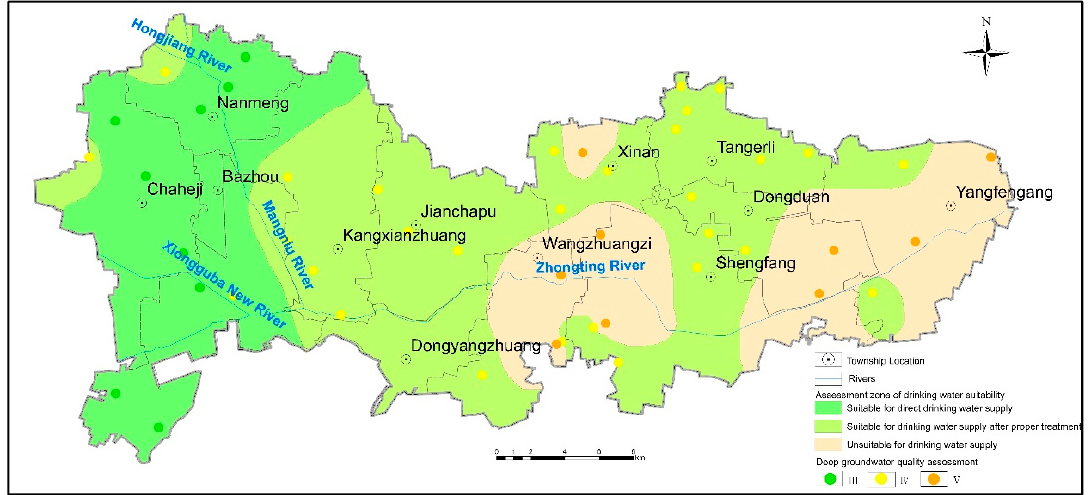
Figure 8. Division diagram of deep groundwater suitable for drinking.